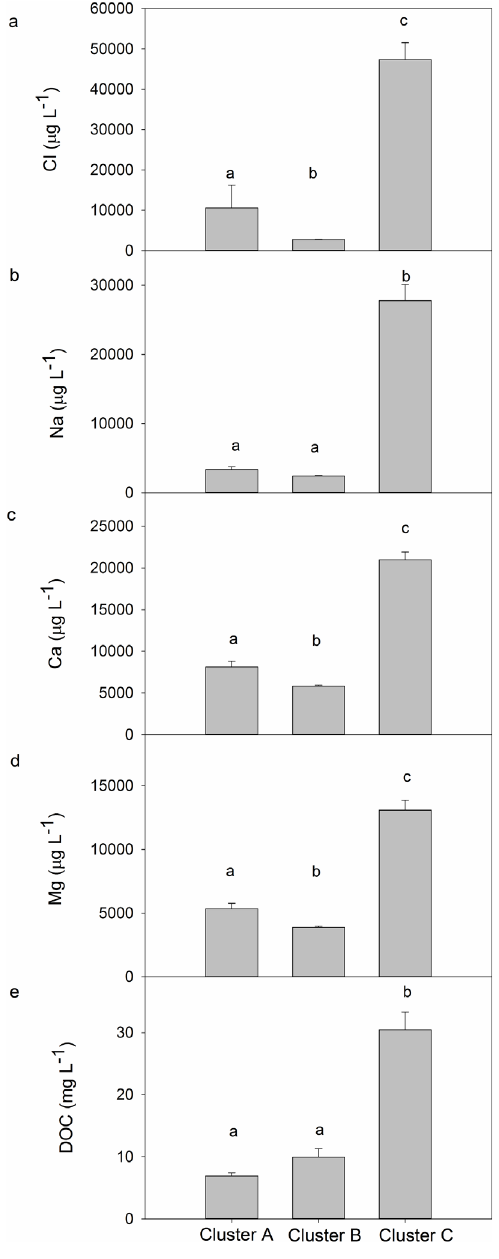
Fig 3. Regional differences in (a) chloride (Cl), (b) sodium (Na), (c) calcium (Ca), (d) magnesium (Mg), and (e) DOC in lakes across southwest Greenland. Bars represent 1 SE of the mean, and letters represent significant differences (p < 0.05) based on post-hoc comparisons of ln-transformed